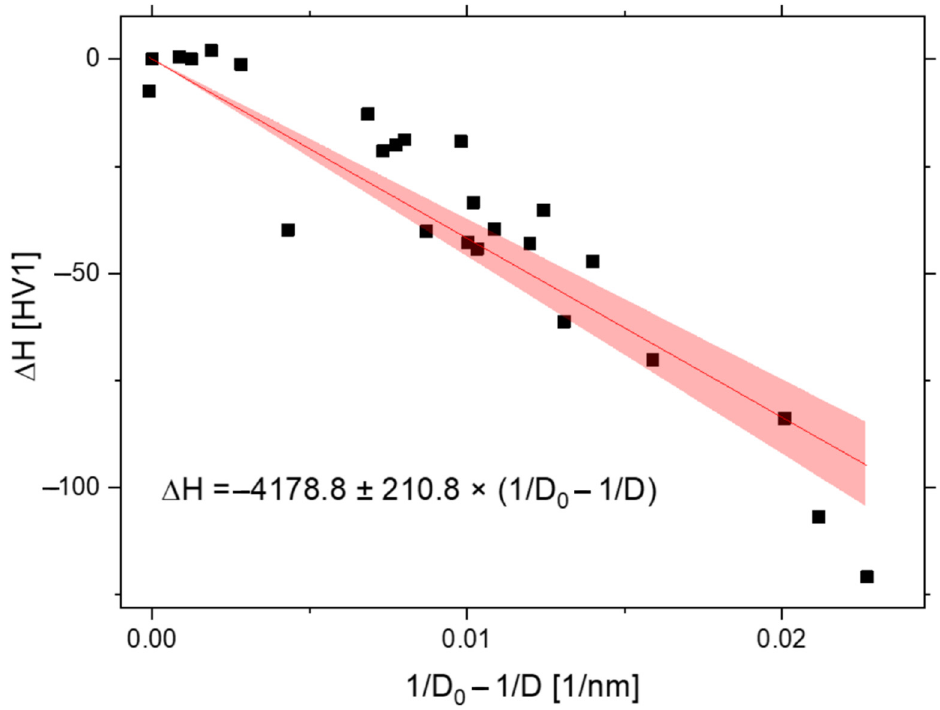
Figure 8. The correlation of the hardness reduction (H) with increasing average diameter of the oxides (1/D0 − 1/D). oxides (1/D0 −